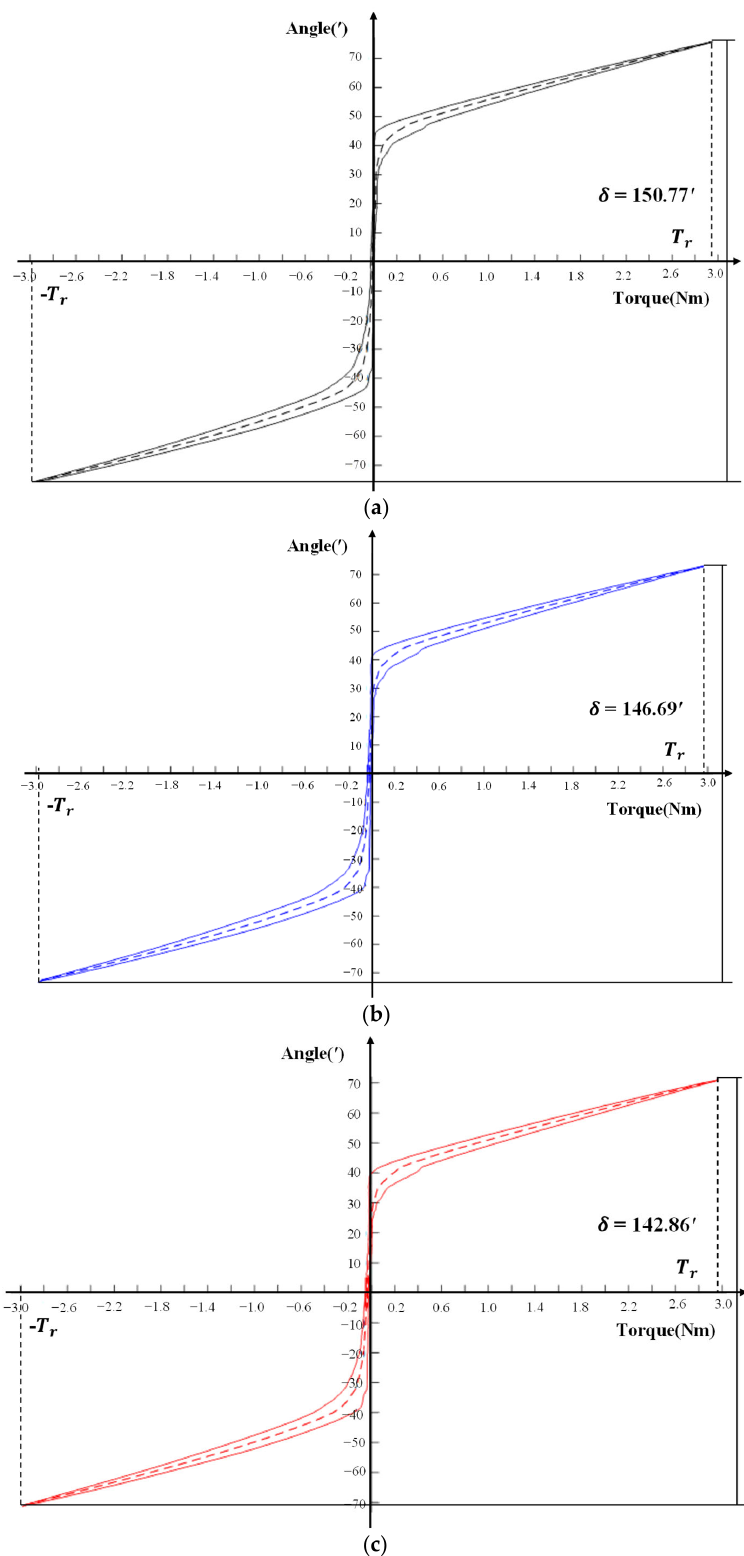
Figure 16. Hysteresis curve of reducer 1 during the first test at three positions of 0 ◦ , 180 ◦ and 360 ◦